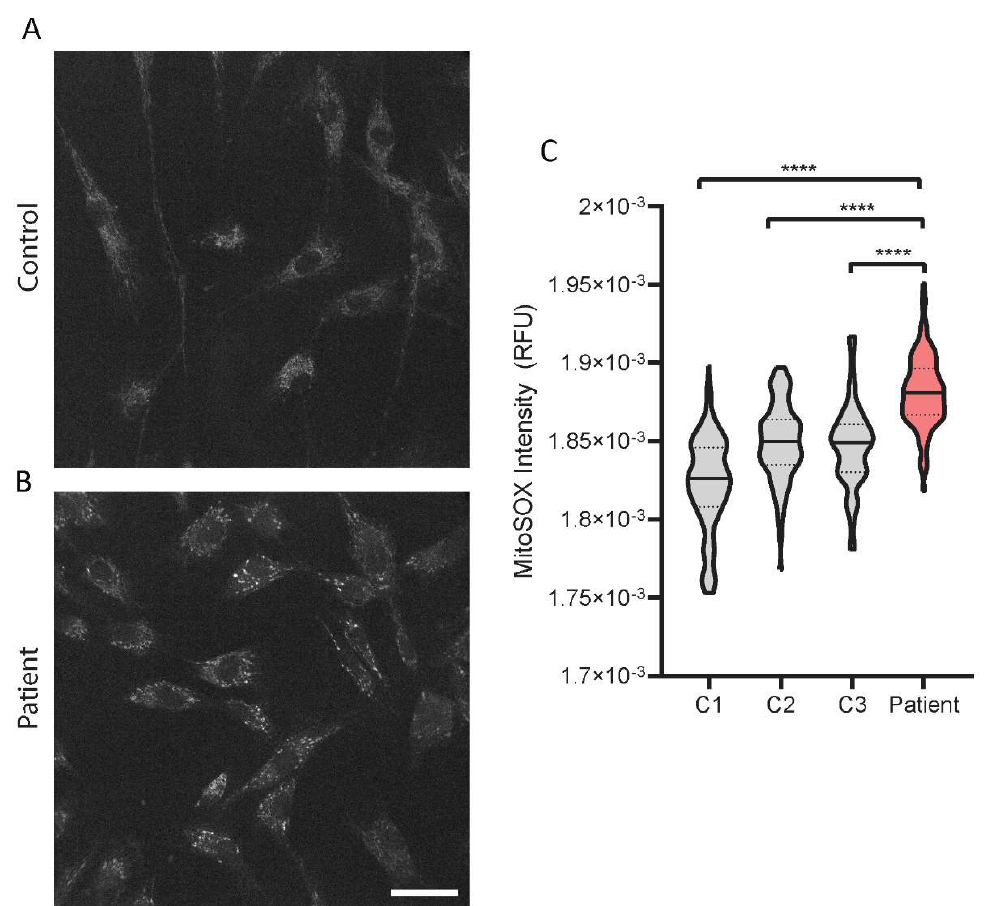
Figure 6. Mitochondrial superoxide levels in patient fibroblasts . Patient and control fibroblasts were incubated with the mitochondrial superoxide probe, MitoSOX, prior to imaging with a spinning disc confocal microscope. Representative greyscale images of MitoSOX fluorescent staining for ( A ) one control and ( B ) patient show an increase in MitoSOX intensity in the patient fibroblasts compared to controls. ( C ) Quantification of the relative fluorescent intensity (RFU) in the patient fibroblasts showed a significant increase in the fluorescent intensity in the patient fibroblasts compared to the three paediatric control fibroblasts. All images were taken during the same session with the same microscope parameters. Scale bar represents 50 µ m. All images shown have the same intensity settings. Representative data from one experiment from 40–150 cells/sample for three control fibroblast lines and one patient fibroblast line. Repeat experiments show similar results. One-way ANOVA with Sidak’s multiple comparisons test; **** p ≤